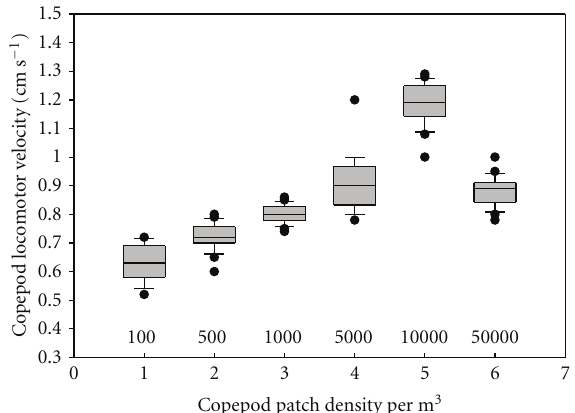
Figure 9: Box-and-whisker plot showing range of copepod ( Calanus ) locomotor velocity ( N = 35, with median and 25th and 75th percentiles as edges of box, and whiskers as 10th and 90th percentiles), related to patch density (from 100 to 50 K m − 3 ), recorded in light, with flow = 60 cms − 1 , at 20 degrees